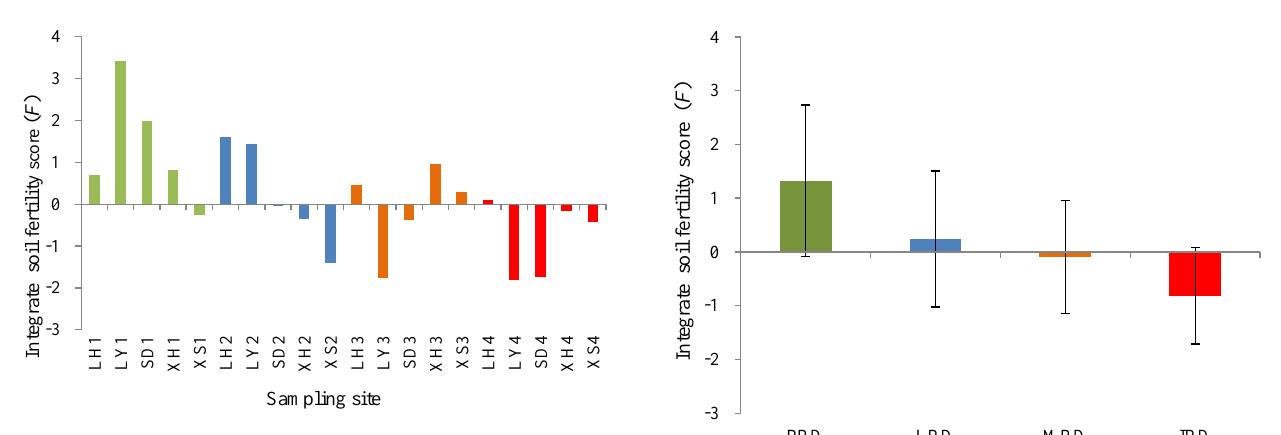
Figure 1. Integrate soil fertility scores of 20 studied plots. LH, LY, SD, XH, and XS are the sampling plots standing for Longhui, Lianyuan, Shaodong, Xinhua, and Xinshao counties at central Hu- nan province, China, respectively. The green, blue, orange, and red bars refer to potential, light, moderate, and intensive rocky deserti- fication, respectively.